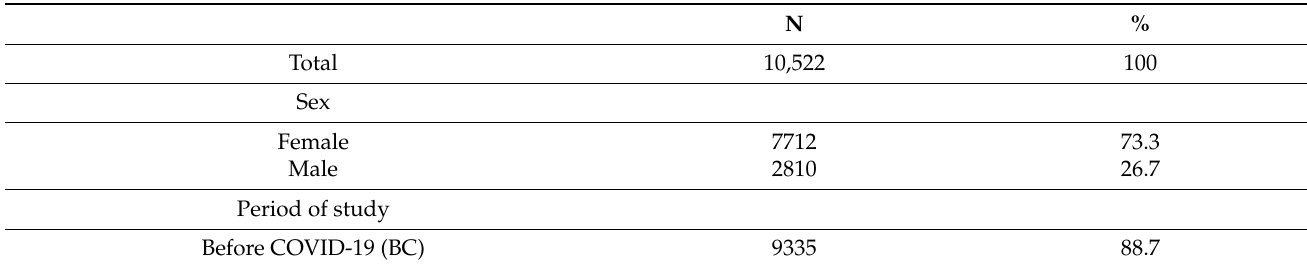
Table 1. Sociodemographic characteristics of the